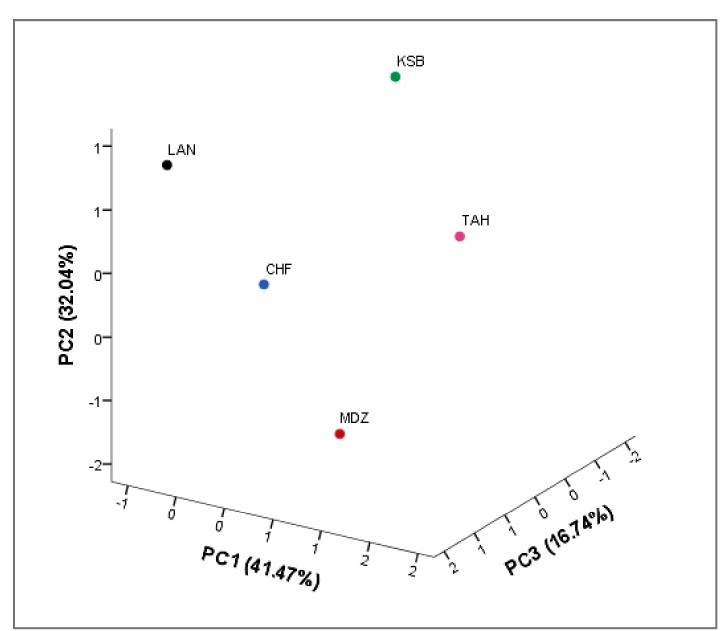
Figure 3. Scatter plot for the first three principal components (PC1 / PC2 / PC3, 89.79% of total variance) for the studied strawberry tree genotypes based on their physicochemical and biochemical